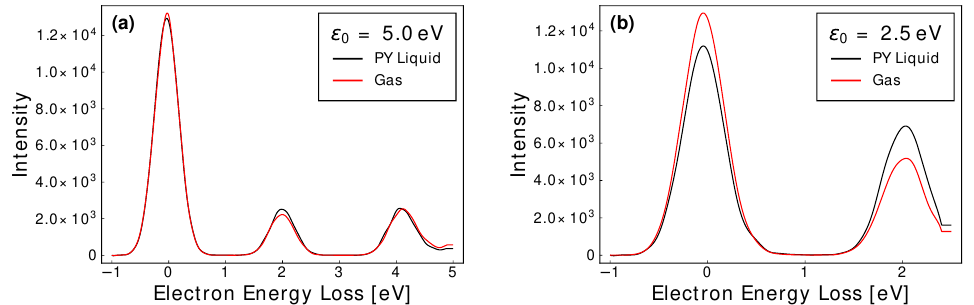
Figure A7. An elastic and inelastic EELS, with the Percus-Yevick liquid structure factor result (Black) compared with the equivalent gas phase result (Red). In each model, an inelastic threshold of 2 eV was used with incident energies of 5 eV ( a ), and 2.5 eV ( b ). As coherent scattering is predominantly restricted to low energies (<5 eV), its effects are minimal when the incident energies exist outside that